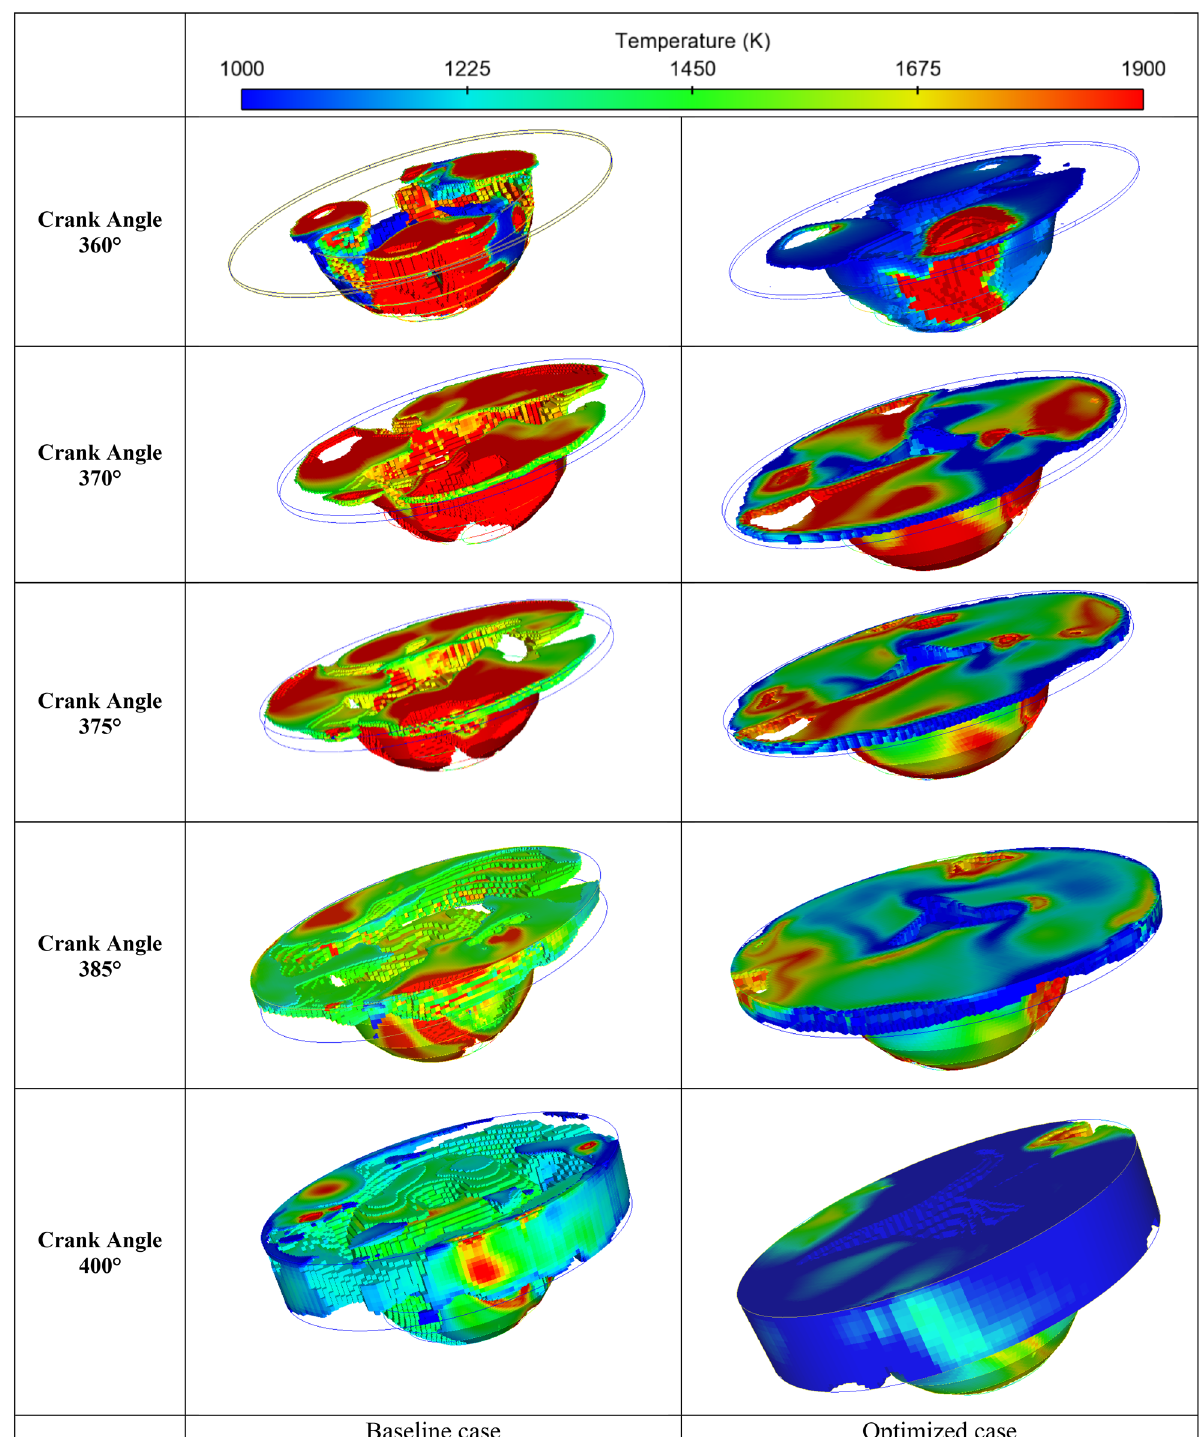
Fig. 12 Equivalence ratio distribution of baseline and optimized cases at different crank